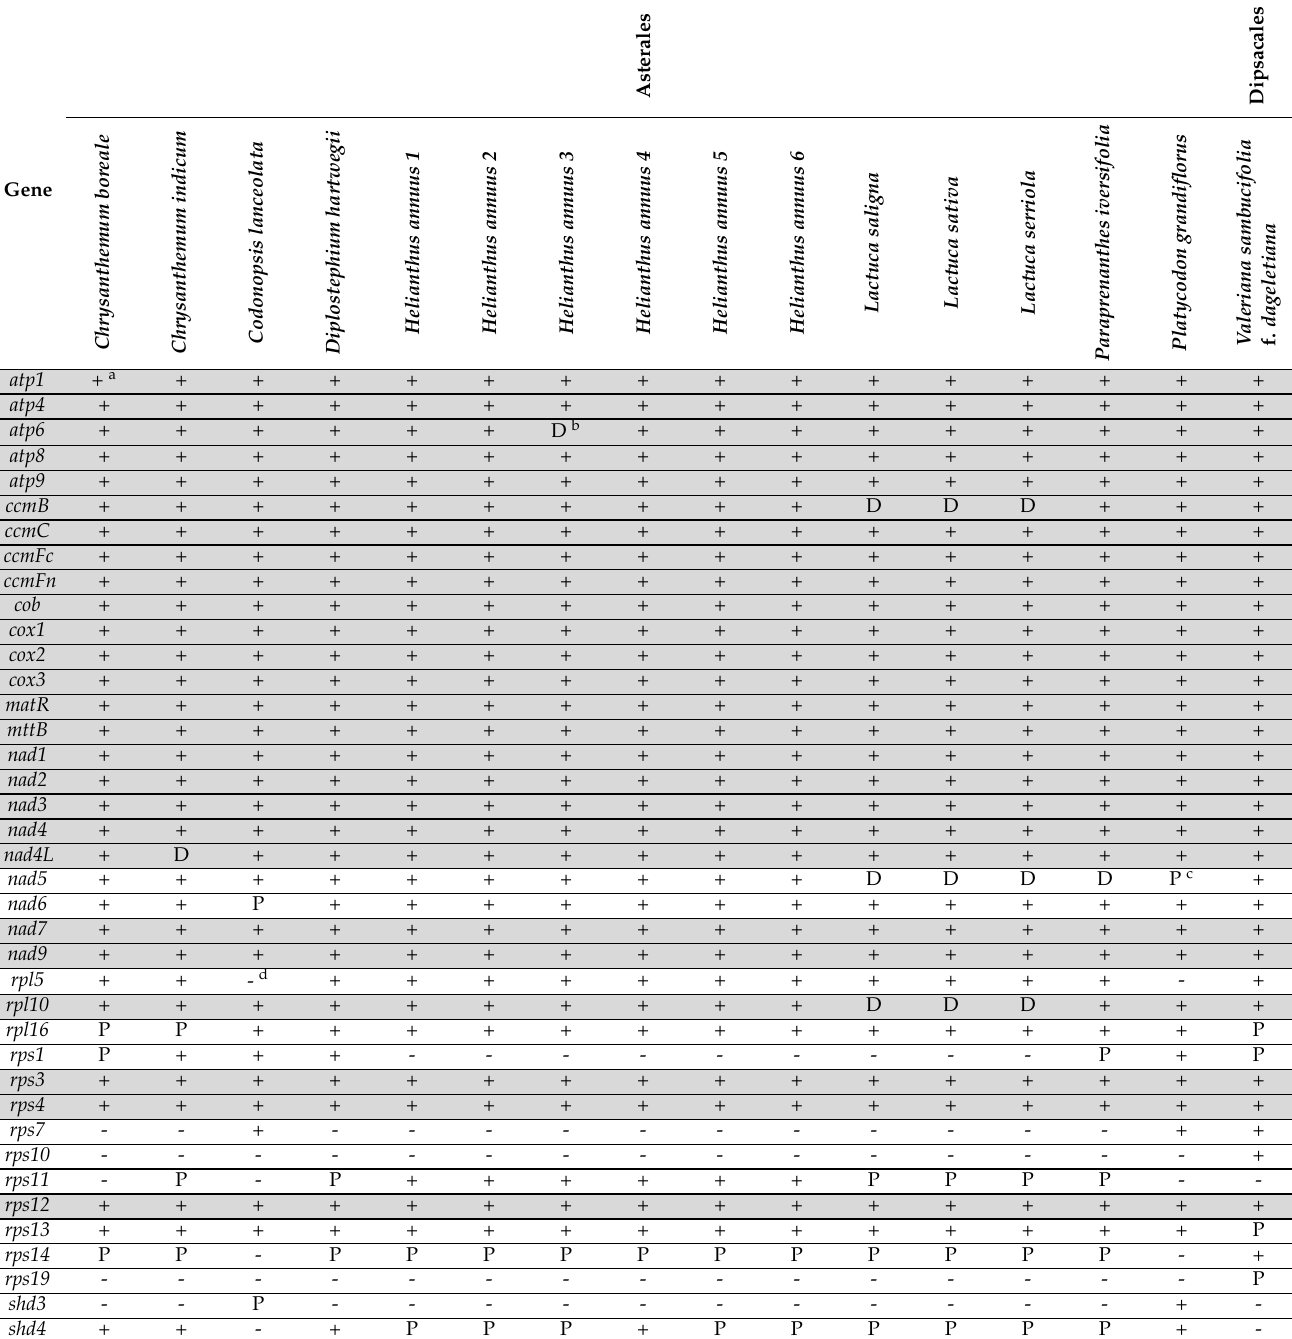
Table 1. Mitogenome-coding genes in V. sambucifolia f. dageletiana compared with those in species in the order Asterales. The shaded rows indicate conserved genes in the orders Asterles and